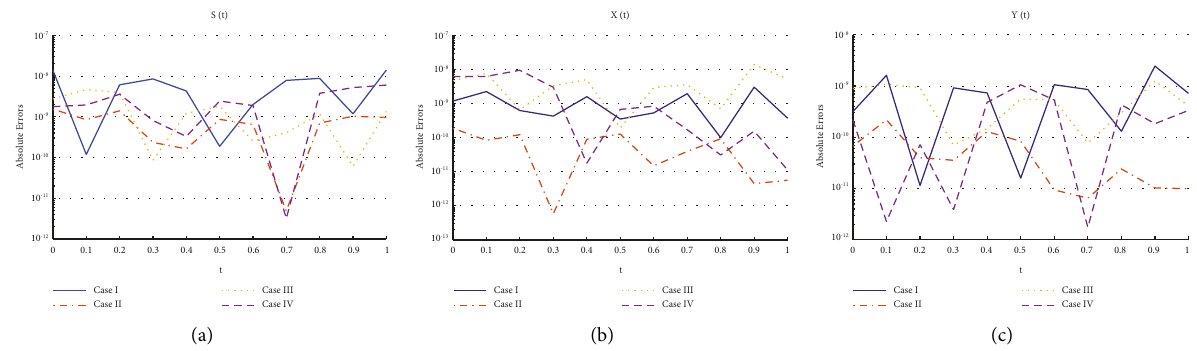
Figure 10: Absolute errors obtained by the LeNN-WOA-NM algorithm under the influence of variations in α the prey-predator model. (a) Population density of local prey. (b) Population density of immigrant prey. (c) Population density of the predator.